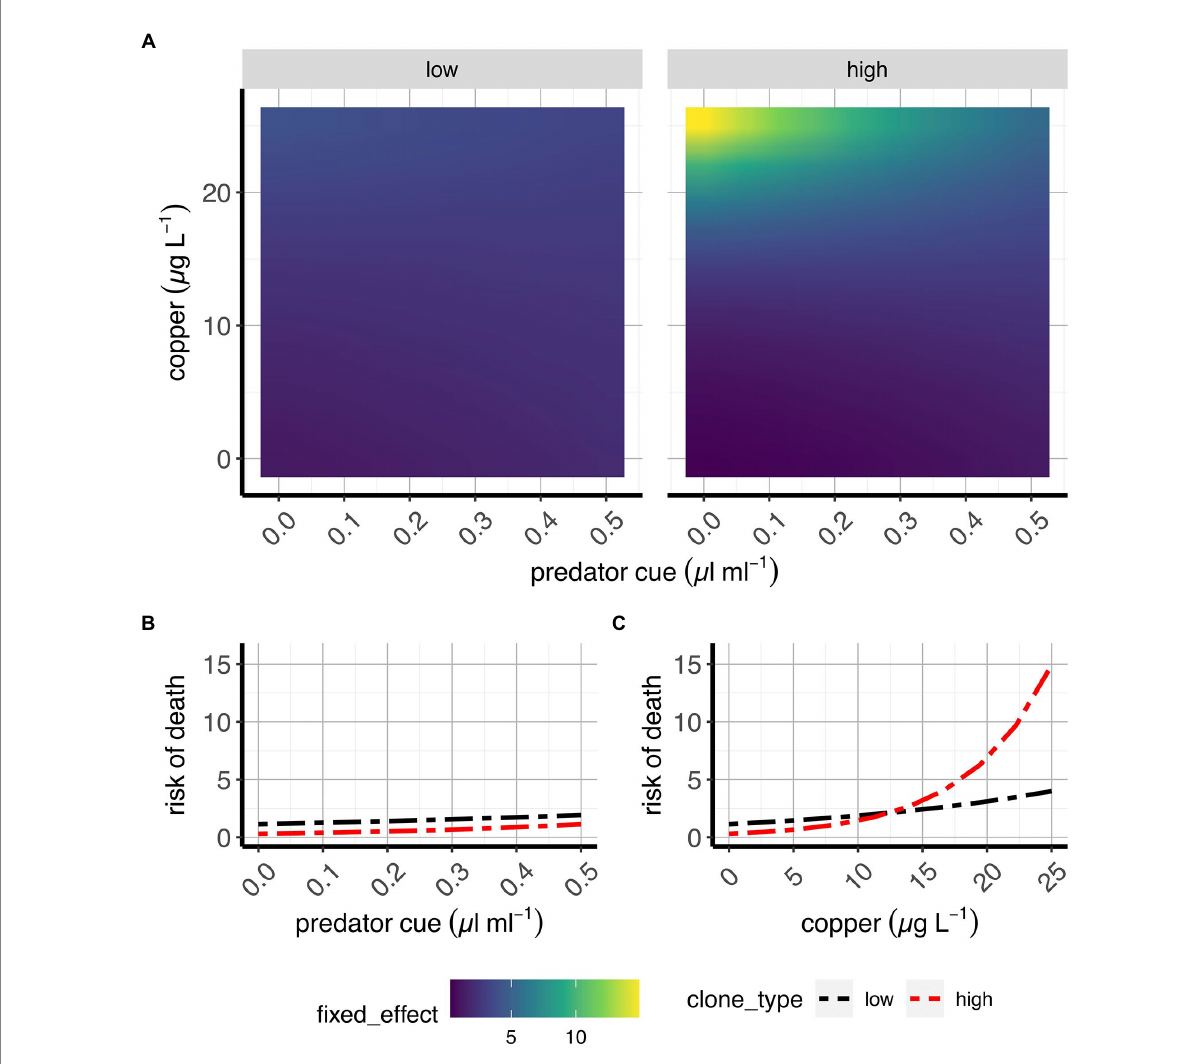
FIGURE 6 Risk of death in two classes of D. pulex genotypes. (A) Contour plots of the average fixed effects portion of the model showing the overall response (here: risk of death before maturity) to copper and predation in “high inducers” and “low inducers.” (B,C) Average effects of risk of predation (B) and sub-lethal copper concentrations (C) on risk of death when copper and risk of predation, respectively, are absent (e.g., references for each treatment). X-axes present predator cue (A,B) or copper concentrations (C) , and y-axis denote copper concentrations (A) or risk of death estimates as risk scores (B,C)